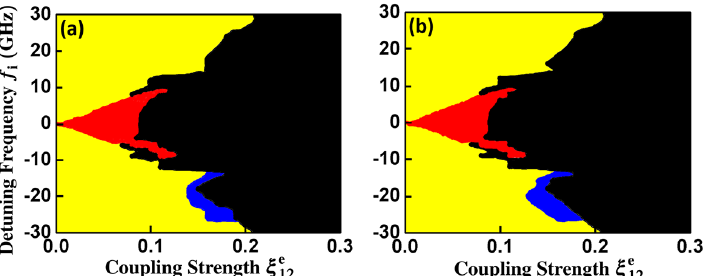
Figure 6. Maps of dynamical states for ( a ) LD1 and ( b ) LD2, respectively, in the mutually coupled laser system when ξ e = ξ e . Regions of mutual injection locking, P1 dynamics, P2 dynamics, and chaos 12 21 are marked by red, yellow, blue, and black,